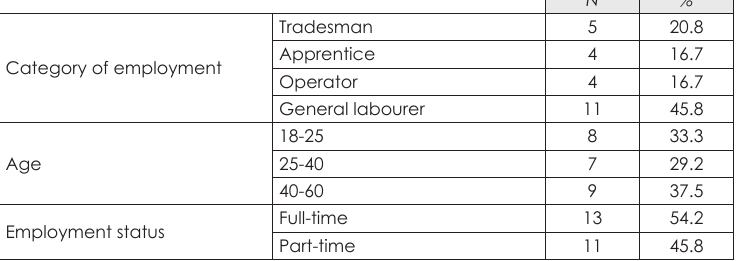
Table 15: Profile of employees